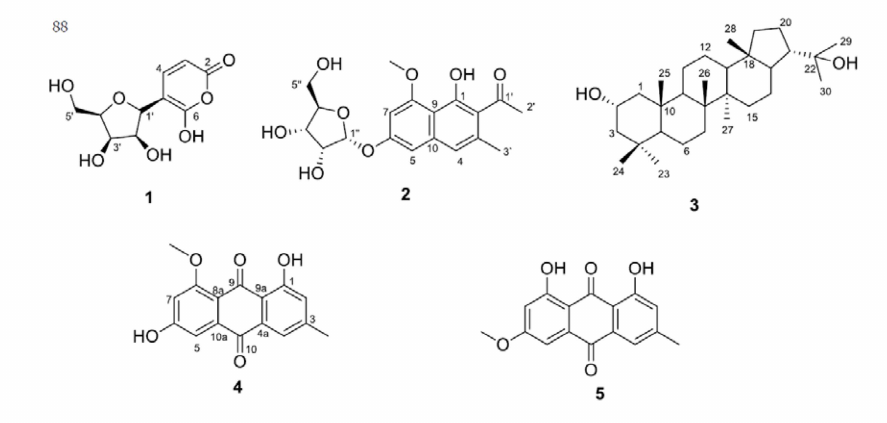
Figure 1. Structures of compounds 1 – 5